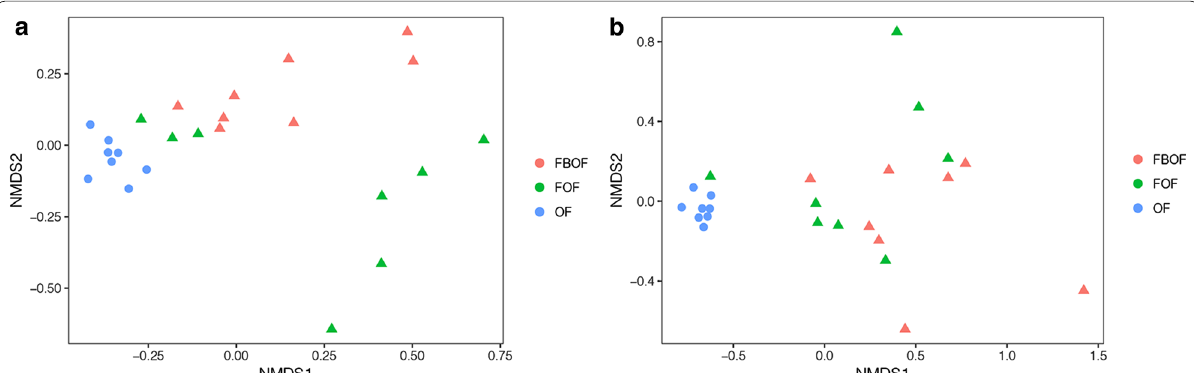
Fig. 2 Nonmetric Multidimensional scaling (NMDS) analysis in bacterial ( a ) and fungal ( b ) microbiome between all sample sets. OF organic fertilizer, FOF dazomet fumigation followed by organic fertilizer, FBOF dazomet fumigation followed by biological organic fertilizer